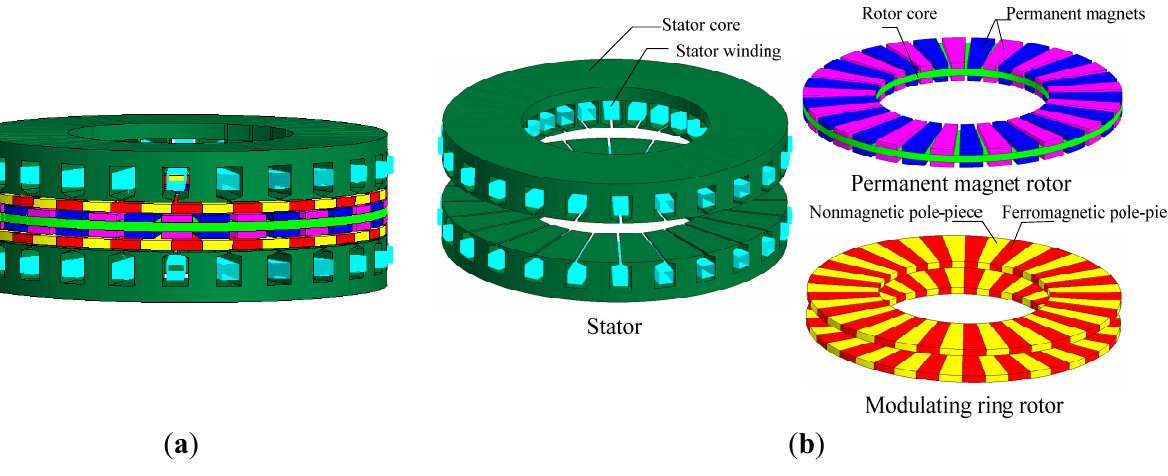
Figure 2. Three-dimensional (3D) simulation model of the axial magnetic-field-modulated brushless double rotor machine (MFM-BDRM): ( a ) overall view; and ( b ) exploded